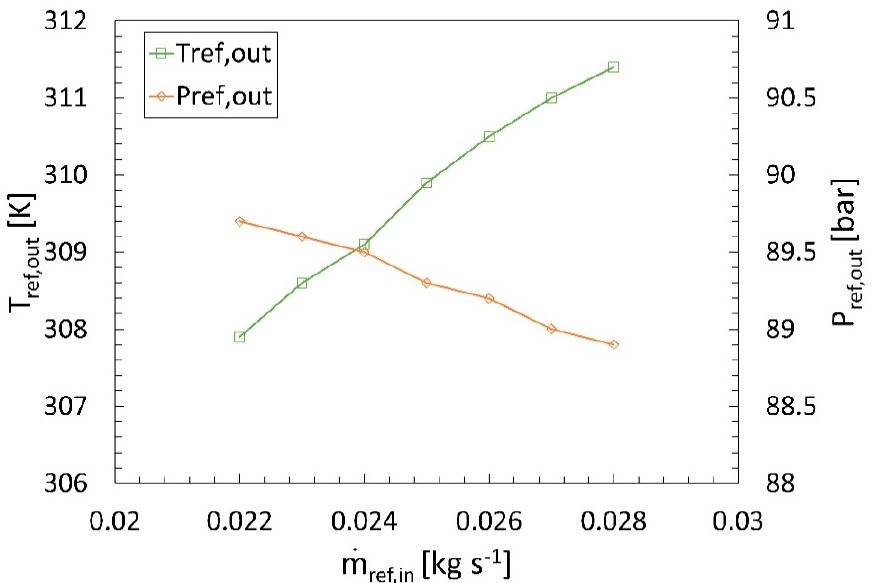
Figure 15. Simulated behavior of the refrigerant outlet temperature and pressure as functions of the mass flow rate. The inlet refrigerant temperature and pressure were fixed to 400 K and 90 bar, respectively, whereas the inlet air temperature was kept at 299